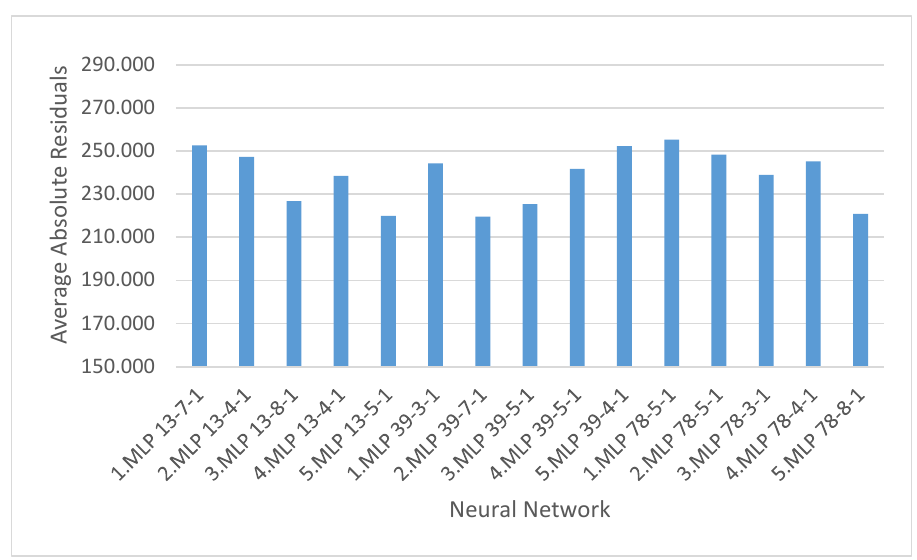
Figure 3. Comparing absolute residuals of equalized time series of RF import from PRC (Source: Author).